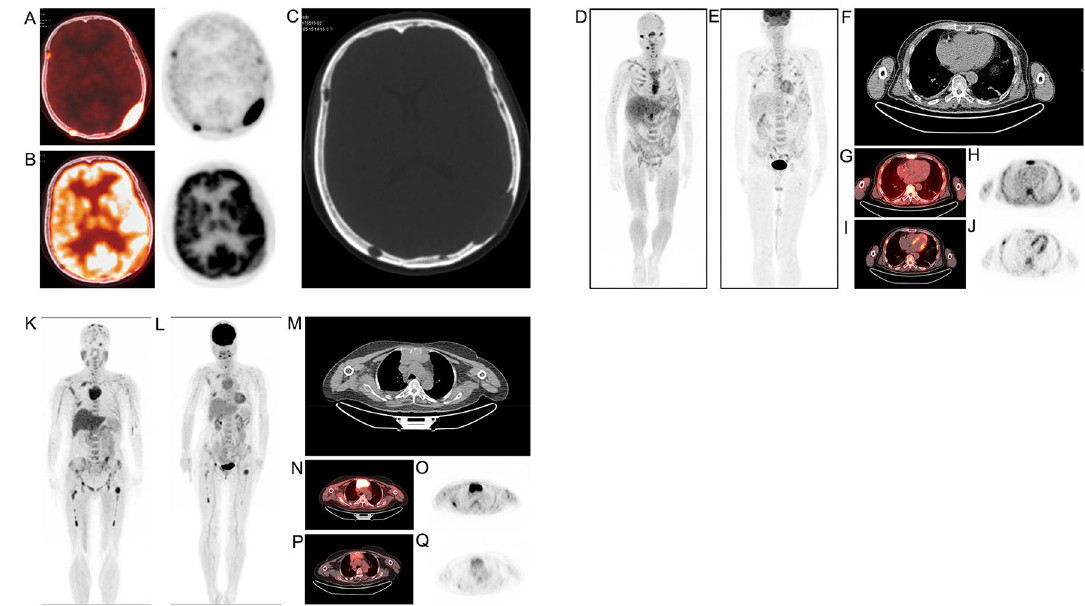
Figure 2. 11C-acetate and 18F-FDG PET/CT images. ( A – C ) 11 C-acetate ( A ) and 18 F-FDG ( B ) PET and CT ( C ) images of the brain of a typical patient, showing multiple osteolytic lesions of the skull. ( D – J ) The 11 C-acetate and 18 F-FDG PET/CT images in a patient with multiple rib fractures : 11 C-acetate maximum-intensity-projection PET image ( D ); 18 F-FDG maximum-intensity-projection PET image ( E ); CT image ( F ); 11 C-acetate PET/CT axial fusion image ( G ); 11 C-acetate axial PET image ( H ); 18 F-FDG PET/CT axial fusion image ( I ); 18 F-FDG axial PET image ( J ). The 18 F-FDG PET images ( E , I , J ) show multiple FDG-avid lesions (false positives) of the bilateral ribs, with fracture line shown on the CT image. The 11 C-acetate PET images ( D , G , H ) show no focal lesions. ( K – Q ) The 11 C-acetate and 18 F-FDG PET/CT images of a typical patient with extramedullary disease : 11 C-acetate maximum-intensity-projection PET image ( K ); 18 F-FDG maximum-intensity-projection PET image ( L ); CT image( M ); 11 C-acetate PET/CT axial fusion image ( N ); 11 C-acetate axial PET image ( O ); 18 F-FDG PET/ CT axial fusion image ( P ); 18 F-FDG axial PET image ( Q ). Both 11 C-acetate ( K ) and 18 F-FDG ( L ) PET images show diffuse and focal involvement of the bone marrow. The CT image shows a mass with soft tissue density posterior to the sternum, which is both 11 C-acetate- ( N , O ) and 18 F-FDG- ( P , Q ) avid. (Images by MIM Encore of MIM Software Inc., version number: 6.6.11_buildH213-00, URL: https:// www. mimso ftware. positives at fracture sites. AC-PET was more capable than FDG-PET in distinguishing an old fracture from an active tumor lesion (Fig. 2D–J). As shown in Fig. 3, the positive rate of marrow involvement detected by AC-PET was 93.8% (60/64), includ- ing 34 patients with both diffuse and focal hypermetabolic lesions, 21 patients with diffuse lesions only, and 5 patients with focal lesions only. The focal lesions showed a median SUV max of 5.68 (range 1.29–47.60) and were mainly located in the pelvis (41.7%), followed by the long bones of the lower limbs (25%), sternum and ribs (20.8%), craniofacial bones (8.3%), and vertebral bones (4.2%). FDG-PET detected marrow involvement in only 65.6% of patients (42/64), a significantly lower rate than that in AC-PET ( P = 0.004). Of the 42 cases of marrow involvement detected by FDG-PET, 14 were both diffuse and focal hypermetabolic lesions ( P = 0.001), 14 were diffuse involvement only ( P = 0.001), and 14 were focal lesions only ( P = 0.007). In AC-PET, 18.8% of patients (12/64) presented with more than 20 focal lesions, while in FDG-PET, only 6.3% (4/64) were determined to have more than 20 focal lesions ( P = 0.001). AC-PET and FDG-PET detected extramedullary plasmacytomas in the same eight patients with similar sensitivity. The images of a typical patient with extramedullary plasmacytomas are shown in Fig. 2K–Q. Correlation between PET image characteristics and clinical parameters. As indicated in Fig. 4, in the AC-PET group, patients with diffuse high marrow uptake presented with lower hemoglobin (92.49 ± 25.03 vs. 120.44 ± 20.42 g/L, P = 0.002), higher M protein in IgG or IgA patients (35.71 ± 23.20 vs. 16.07 ± 18.40 g/L, P = 0.05), and a higher percentage of bone marrow plasma cells (36.88 ± 23.44 vs 11.74 ± 8.72%, P < 0.001), but with similar calcium and LDH levels (data not shown), compared to patients with negative marrow uptake. In the FDG-PET group, the M protein levels in IgG or IgA subtypes (34.33 ± 20.34 vs. 32.31 ± 25.72 g/L, P = 0.778) and myeloma cell densities in the bone marrow (37.43 ± 22.15 vs. 30.17 ± 24.54%, P = 0.226) were similar between patients with diffuse high marrow uptake and those with negative uptake. However, a significantly lower hemoglobin level was detected in those with diffuse high bone marrow uptake than those with negative uptake (86.79 ± 19.56 vs. 103.92 ± 28.42 g/L, P = 0.008). Diffuse high marrow uptake in AC-PET was positively correlated with high-risk disease characterized by the presence of high-risk cytogenetic abnormalities (r = 0.29, P = 0.020) and the D–S stage (r = 0.39, P = 0.001).